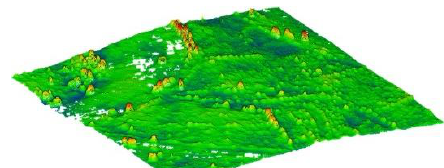
Figure 8 3D visualisation of the TLS return colorized regarding the 3D error map - Inverted error-map